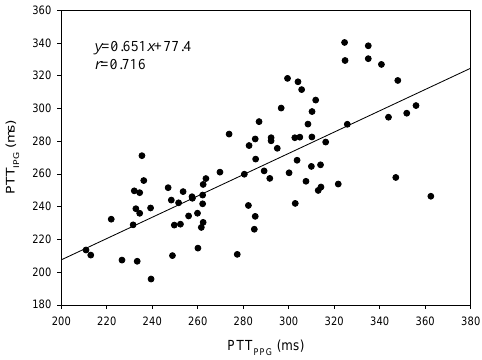
Figure 12. The relationship between the changes of ( a ) the PTT PPG and the changes of systolic pressure, r = 0.450; ( b ) the PTT IPG and the changes of systolic pressure, r = 0.700.